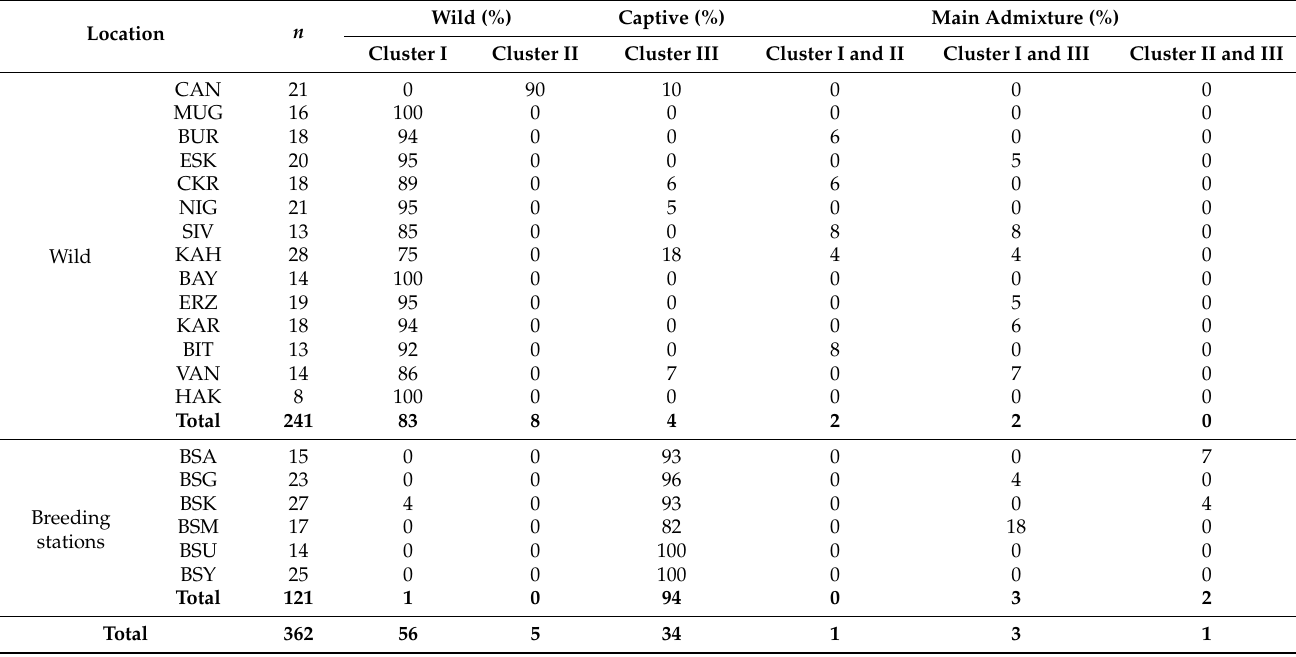
Table 6. Sample size ( n ) and percentages of samples collected in different localities and assigned to the wild (two clusters) or captive cluster at K = 3 in STRUCTURE. Proportion of membership of each pre-defined population in each of the tree clusters ≤ 0.8 are considered